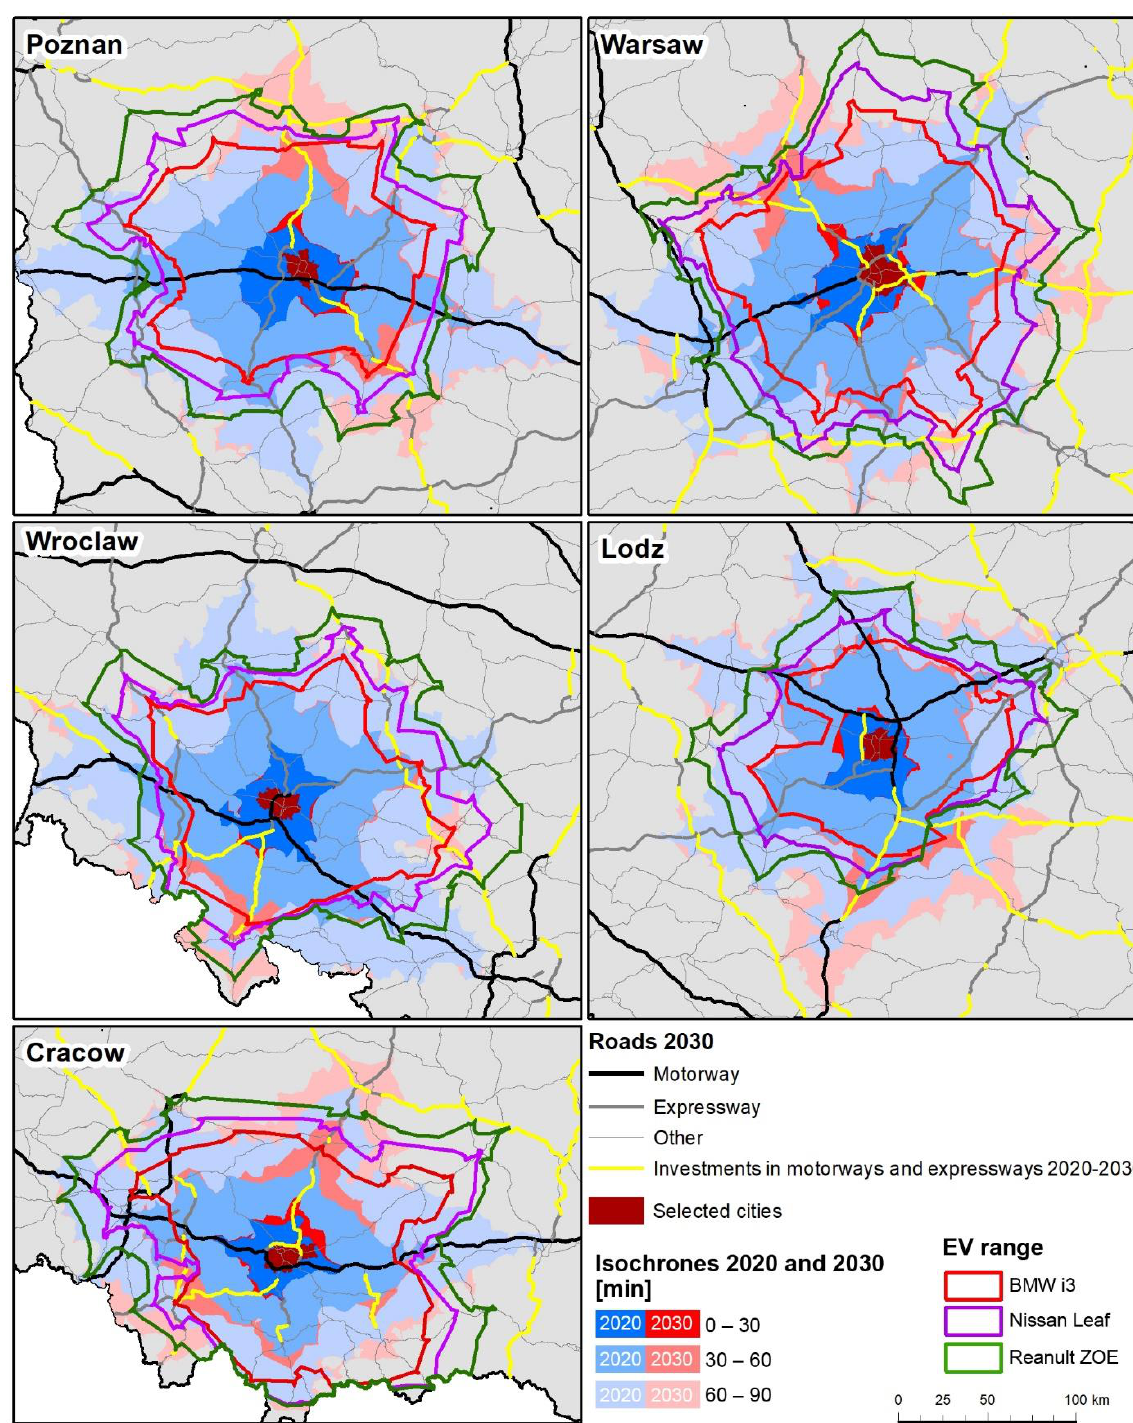
Figure 2. Ranges of the three most popular EVs in Poland used for home-CBD-home travel in 2020 against the background of major planned road projects and changes in the isochrones for access to the five largest Polish cities up to 2030. In presenting the results in Table 1 (Comparison of technological, infrastructural and demographic changes), 2030 is assumed as the baseline. For the infrastructure = constant variant, the difference between 2030 and 2020 results only from changes in the working age population. Meanwhile, for the population = constant variant, the difference stems